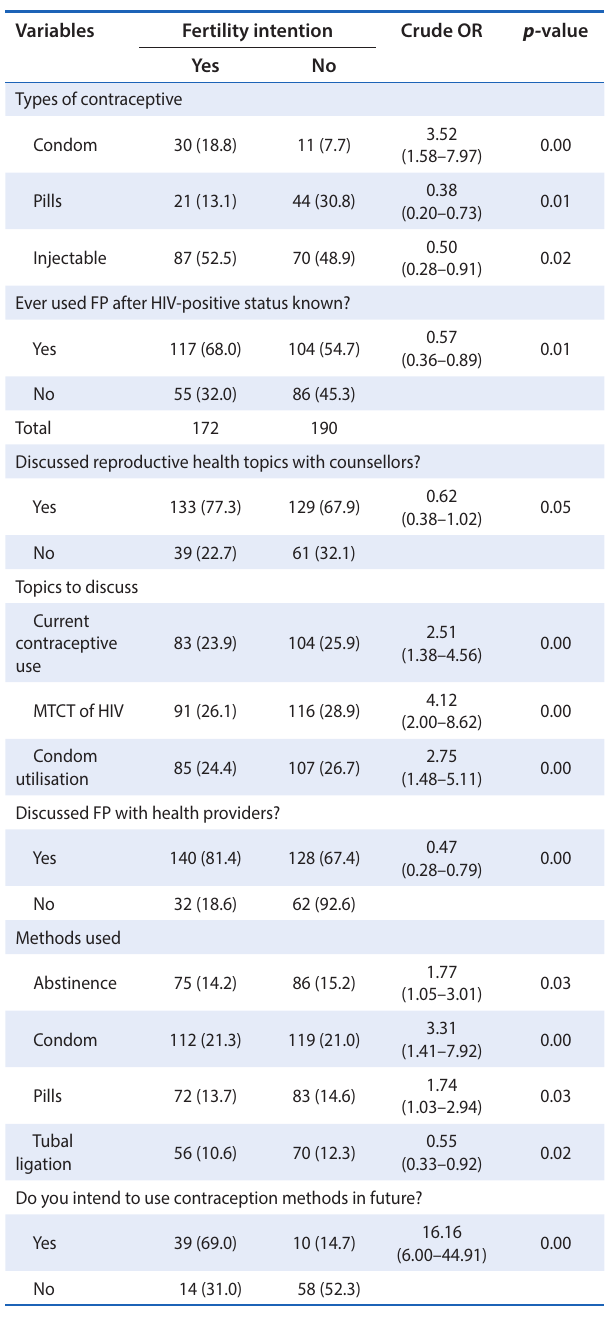
Table 4: Fertility Intention